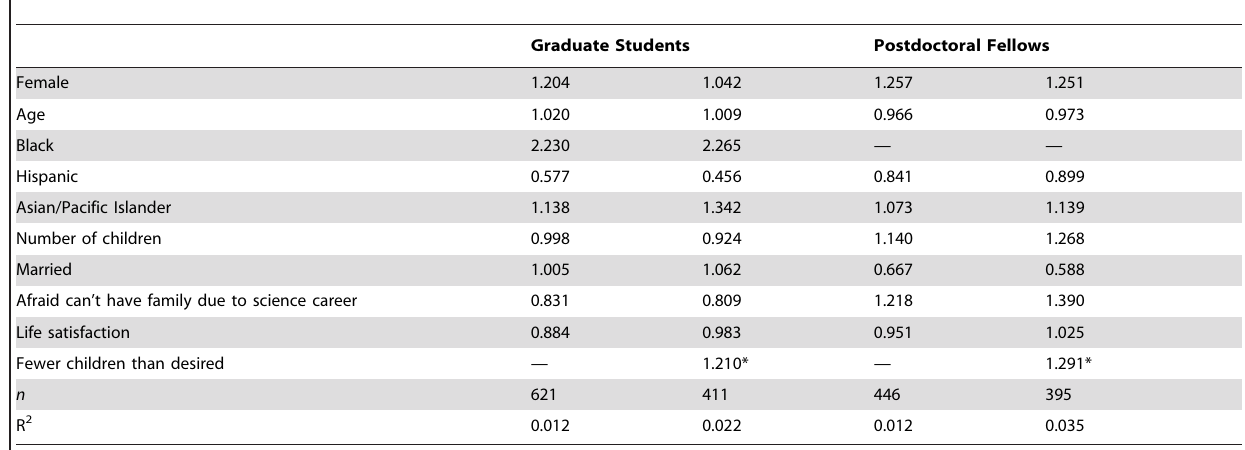
Table 3. Logistic Regression of Plans to Seek a Career Outside of